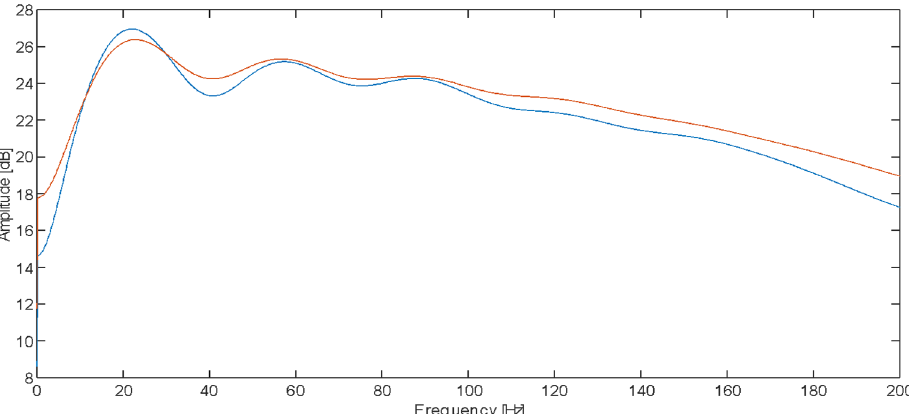
Figure 11. PSD of two excitation signals from EMA when stationary experiment. Similarity of these curves present the repeatability of the EMA experiments.